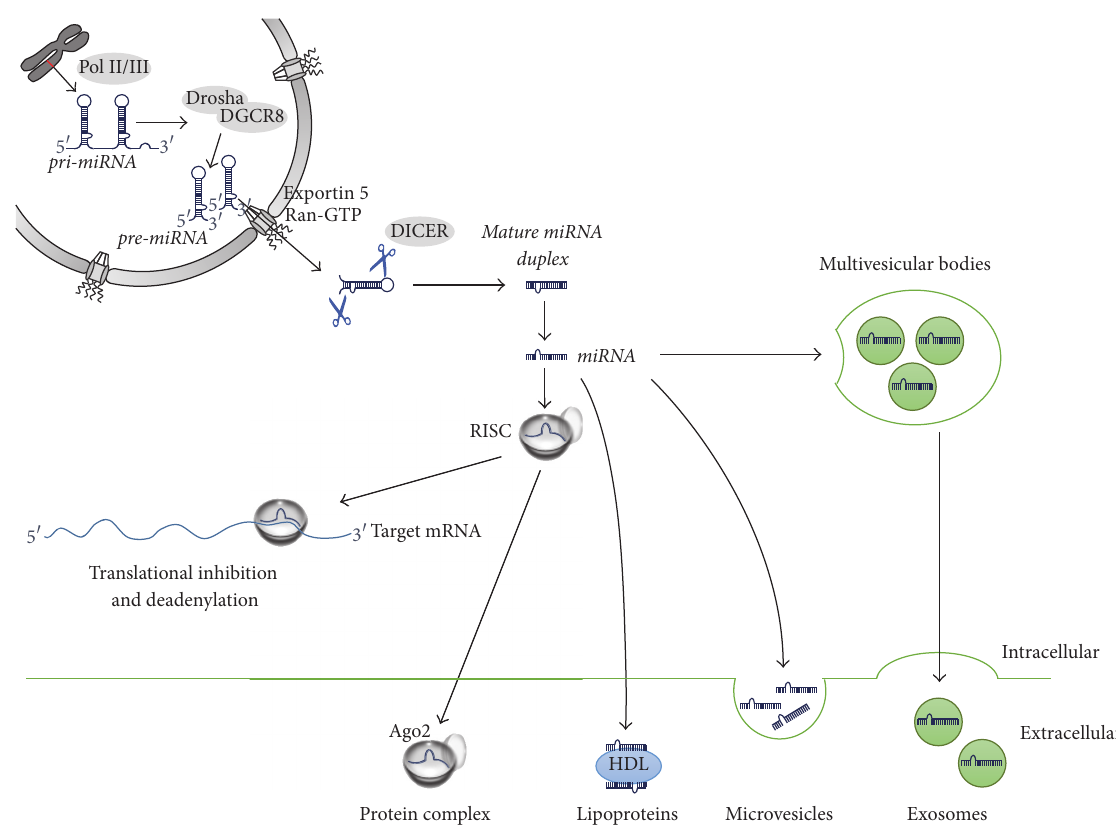
Figure 1: Biogenesis and release of miRNAs. Pri-miRNAs are transcribed in the nucleus by RNA polymerase II/III and processed by the ribonuclease Drosha into hairpin RNAs (pre-miRNA). The stem loops are exported into the cytoplasm using Exportin 5 and Ran-GTP and further cleaved by Dicer to yield 21–23 nucleotide duplexes. The duplexes are unwound and can be loaded directly into the RISC complex and guide translational repression of target mRNAs or they can be released from the cells in protein complexes, bound to lipoproteins, packed in microvesicles, or secreted in exosomes.